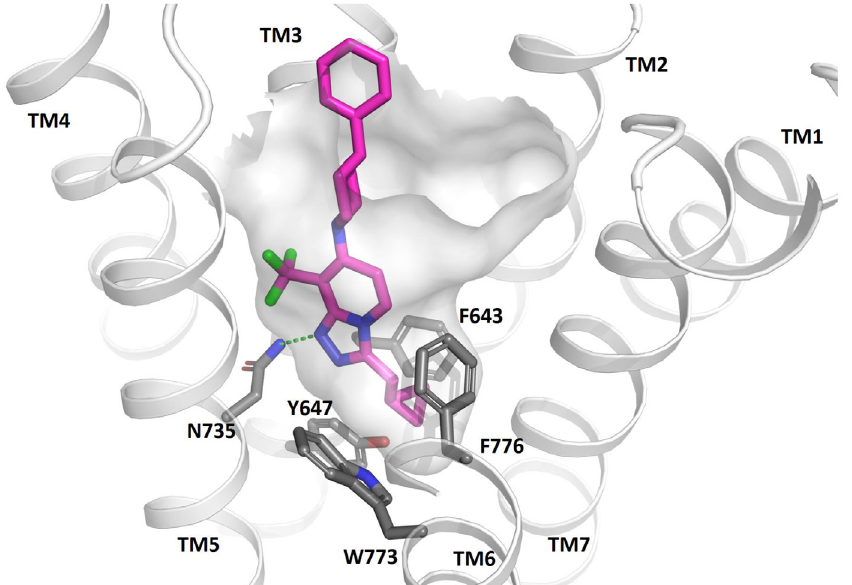
Fig 2. Close up view of the mGluR2 7TM binding site showing the proposed binding mode of JNJ-